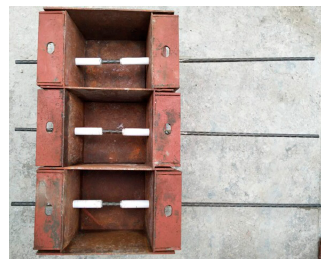
Figure 8. BFRP bars embedded in steel moulds.